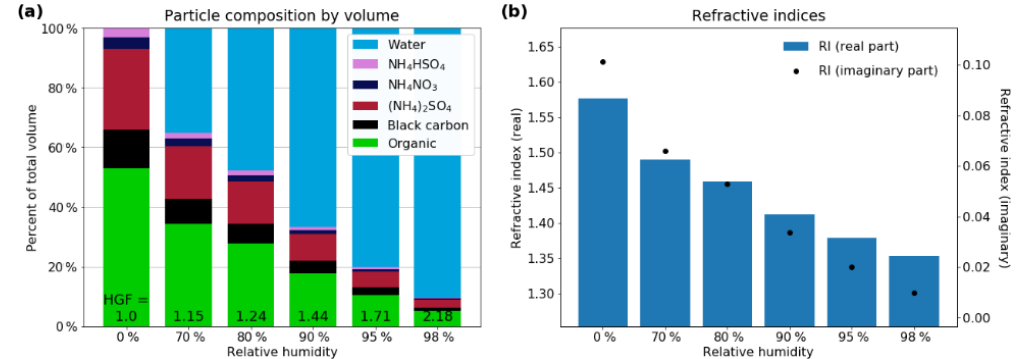
Figure 6. (a) The fractional composition of particles at different relative humidities and (b) the effect of the additional water volume on the particle’s refractive index. These values have been calculated using the ZSR mixing